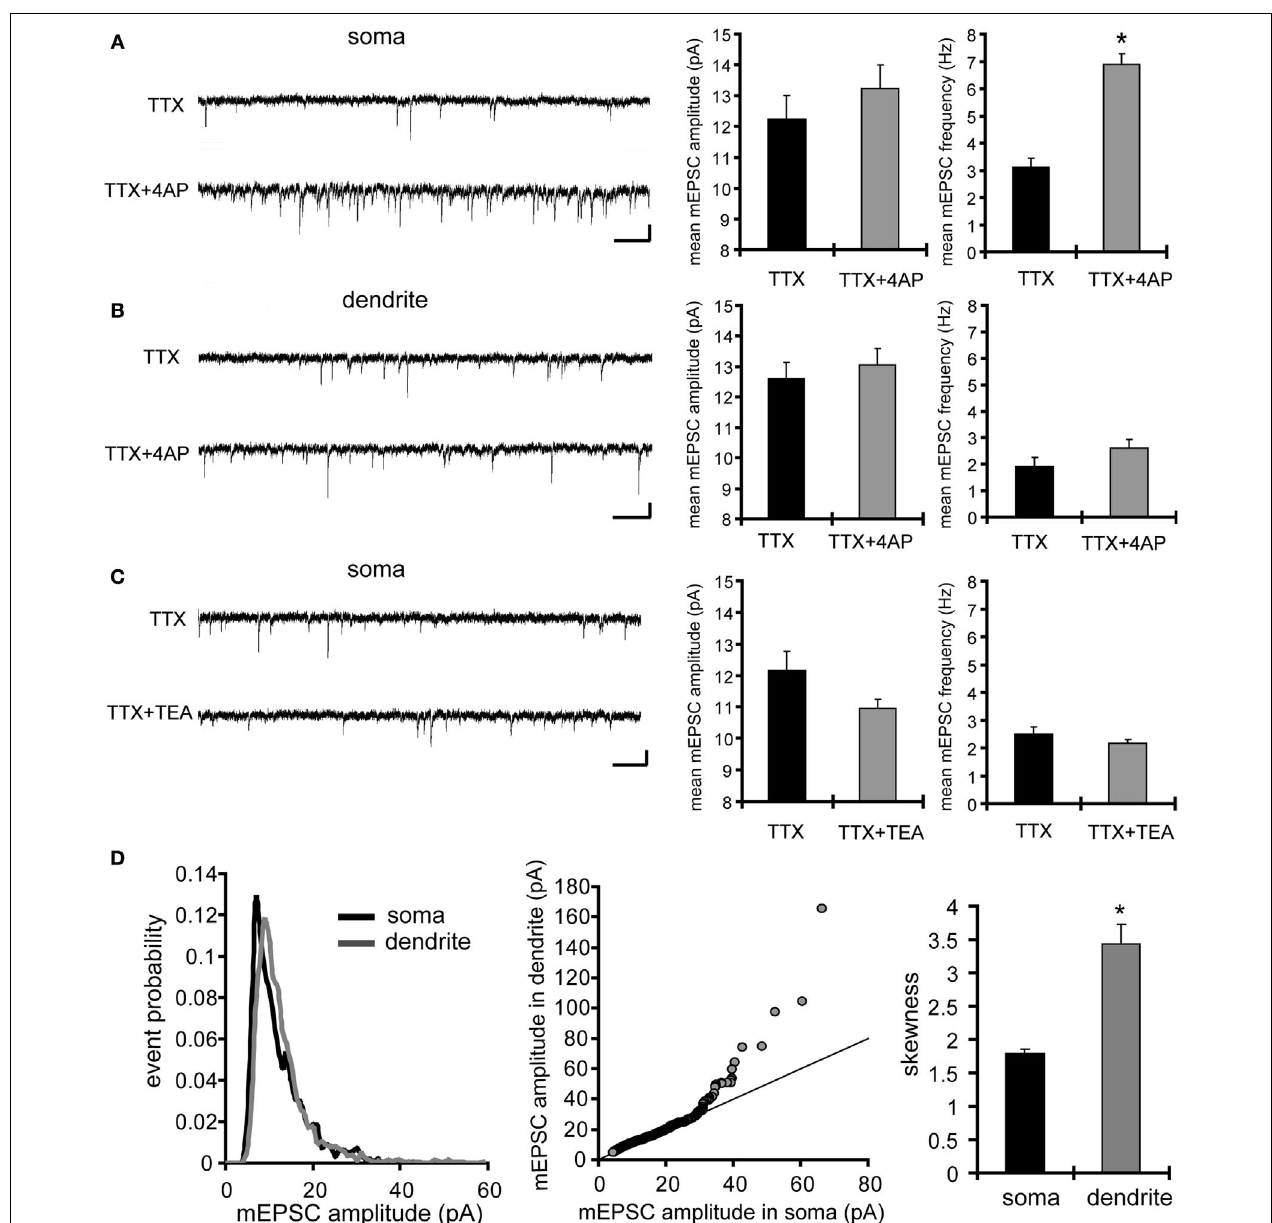
FIGURE 1 | A-type potassium channel blockade enhances the frequency of mEPSCs recorded in the soma, but not the dendrites, of CA1 pyramidal neurons. (A) Representative mEPSCs recorded from the somata of CA1 pyramidal neurons. Hippocampal slices were treated with either TTX (2 µM) alone or TTX + 4AP (5 mM) for 12 h. The slices treated with 4AP showed enhanced mEPSC frequency (TTX: n = 8, TTX + 4AP: n = 9) (scale bar = 10 pA, 500 ms) (* p < 0.05). No apparent difference in membrane properties was observed between experimental groups ( Table 1 ). (B) Representative mEPSCs recorded from the dendrites of CA1 pyramidal neurons. The recorded sites were in the middle of the stratum radiatum, which is approximately 200–250 µm away from the soma. The slices treated with 4AP did not exhibit a signifi cant enhancement of mEPSC frequency in dendrites ( n = 10 for each group) (scale bar = 10 pA, 500 ms). No apparent difference in membrane properties was observed between experimental groups ( Table 1 ). (C) Representative mEPSCs recorded from the somata of CA1 pyramidal neurons. Hippocampal slices were treated with either TTX alone or TTX + TEA (10 mM) for 12 h. TEA-treated slices